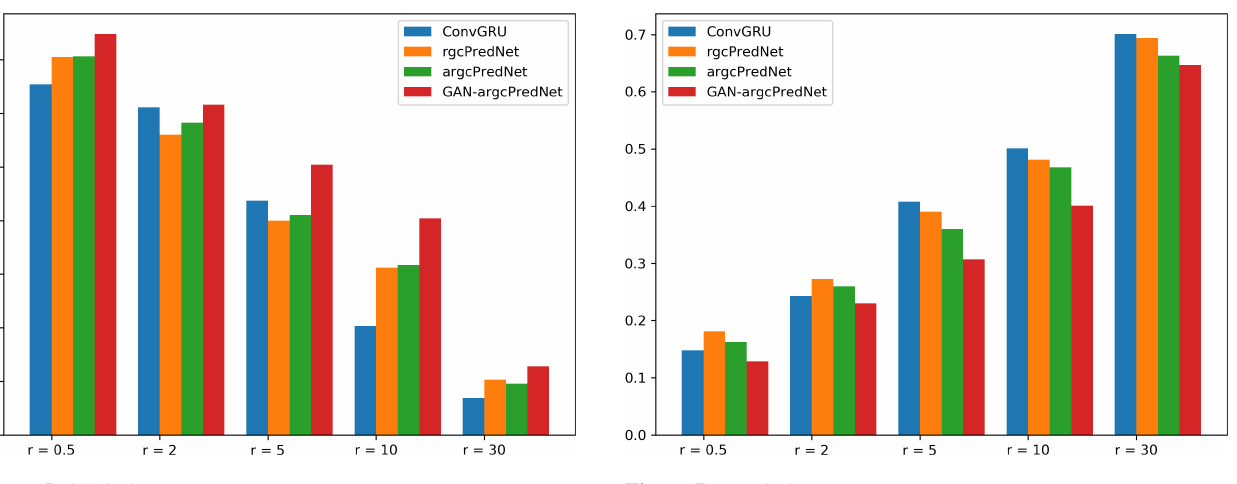
Figure 7. FAR index score. Table 4. Rain